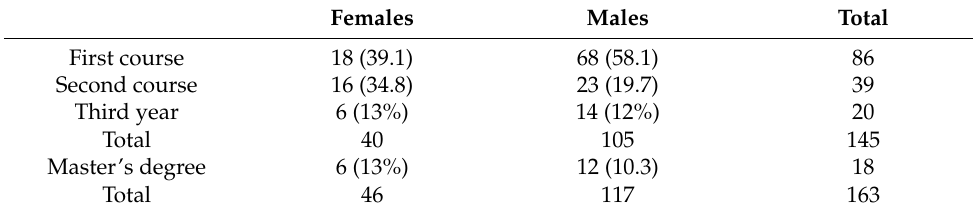
Table 1. Description of the sample according to course and sex.